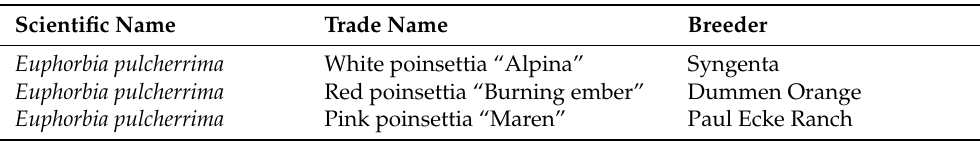
Table A2. Scientific and English names and breeders of three poinsettia cultivars used in the willingness-to-pay online